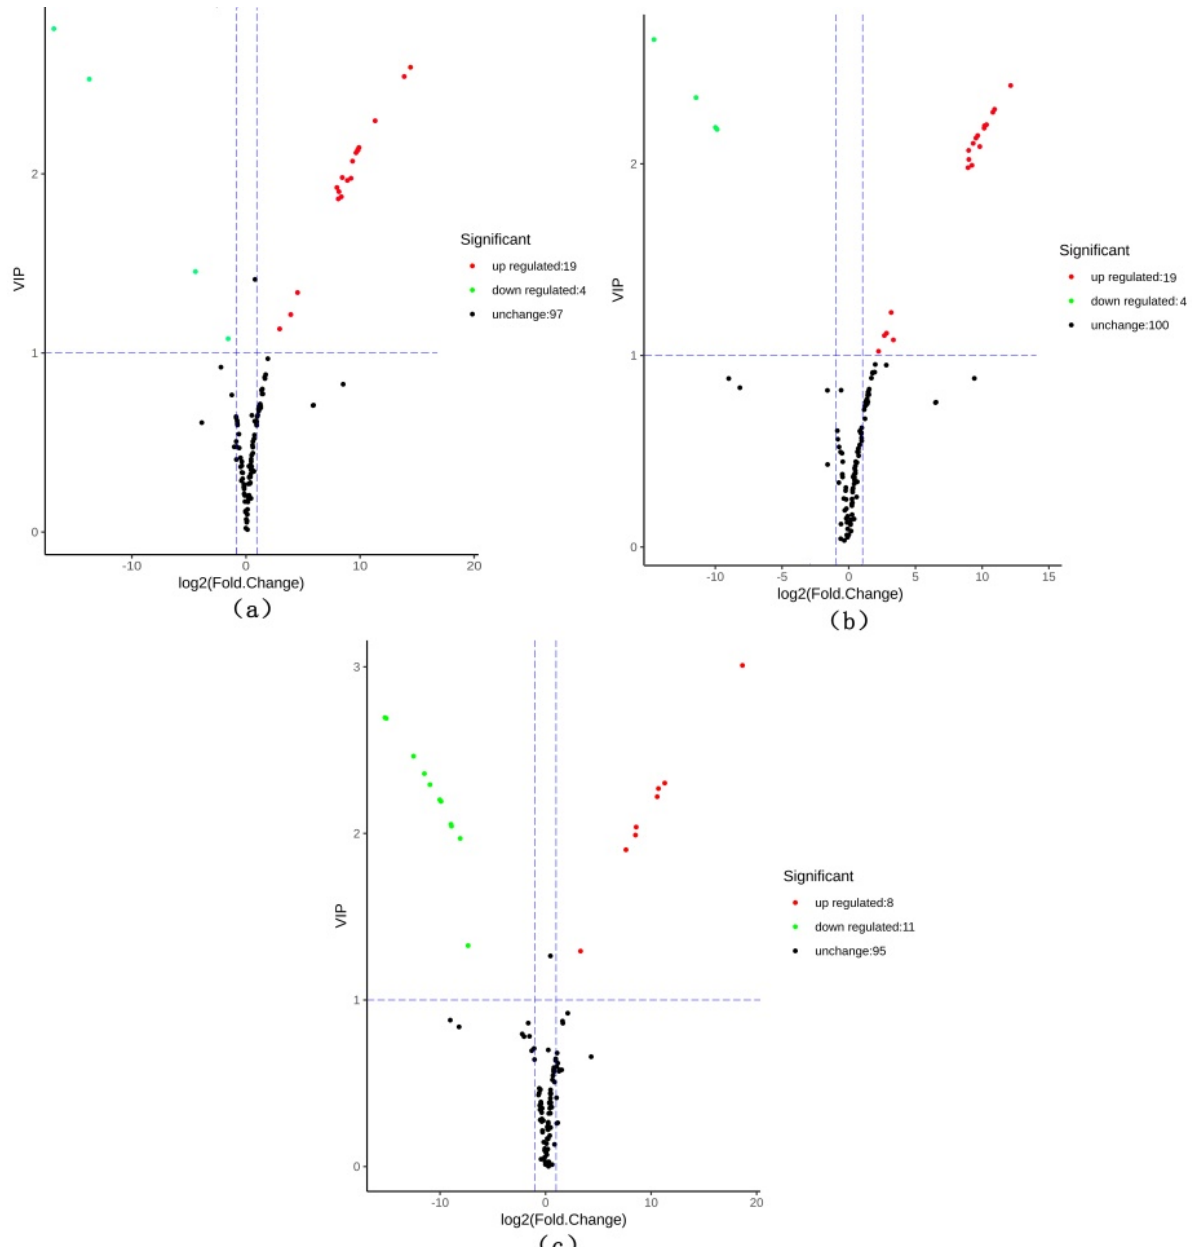
Figure 5. Volcano maps of differential metabolites. ( a ) CSG vs. CHG; ( b ) CSG vs. CFG; and ( c ) CFG vs. CHG. Each dot represents a metabolite; the horizontal axis represents the log of the difference of a metabolite in the two samples, log 2 (fold change). The vertical axis represents the importance of the variable (VIP). The larger the absolute value of the abscissa, the more significant the difference is, which results in screening of the target differential metabolites. The green dots indicate that the differential metabolite was downregulated, the red dots indicate that the differential metabolite was upregulated, and the black dots indicate that the differential metabolite was not significantly changed.